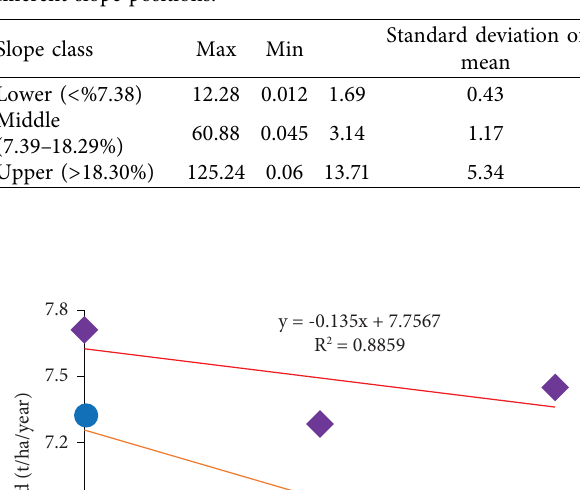
Table 6: Te average soil erosion in t ha 1 yr 1 Kabe watershed for diferent slope positions.